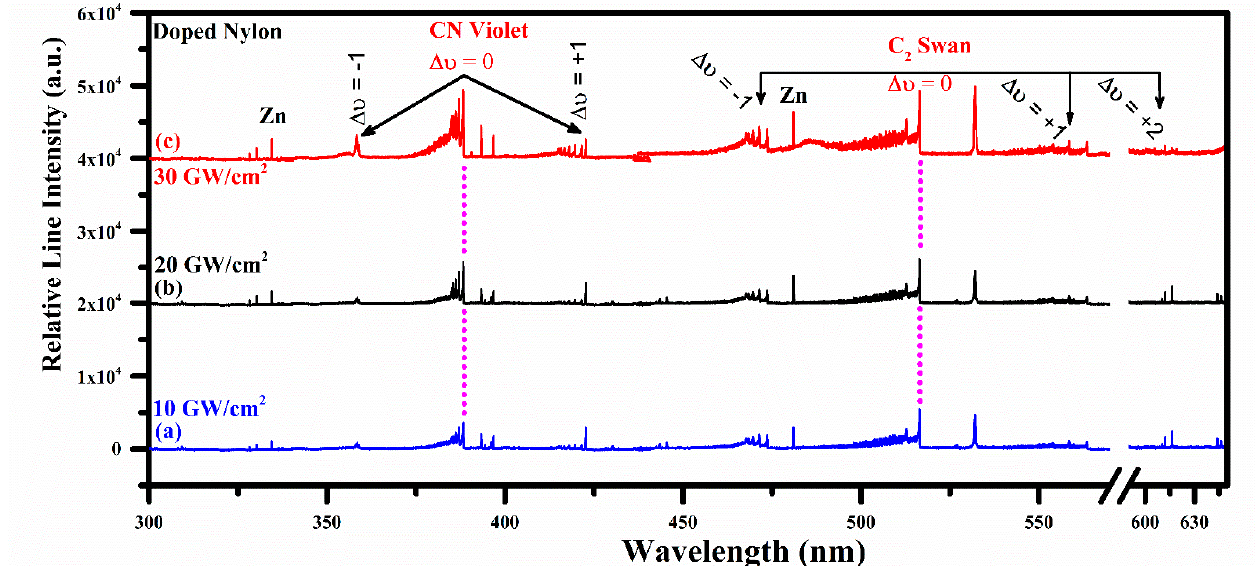
Figure 4 . Time-integrated spectrum of the organic doped nylon from 300 nm to 645 nm showing CN and C 2 vibrational optical emissions together with well-isolated zinc optical spectral lines.